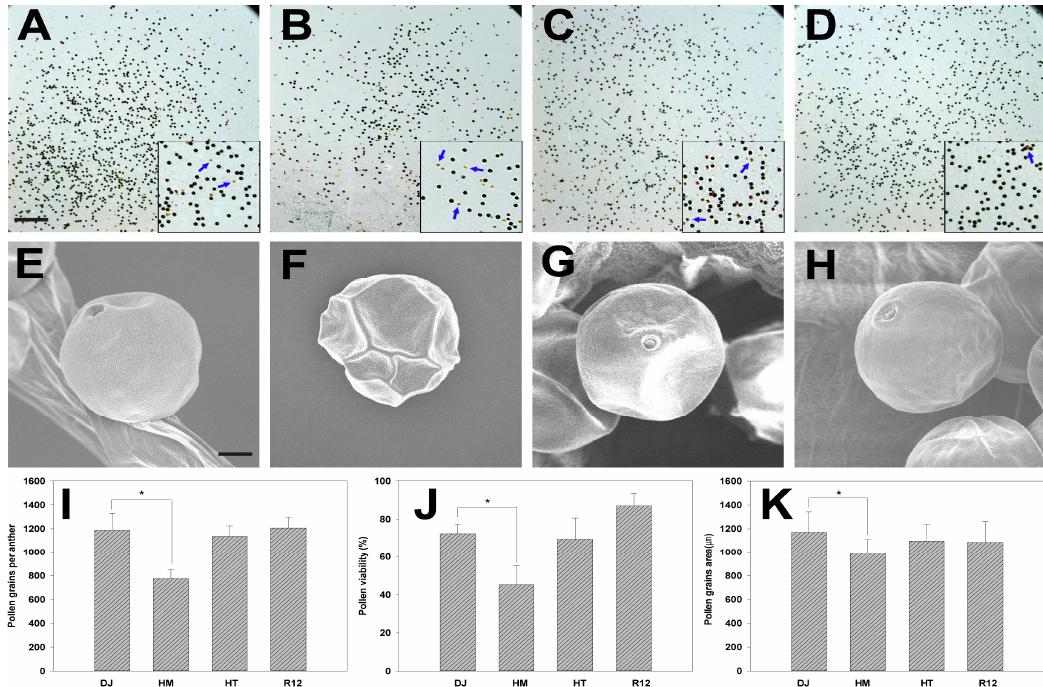
Figure 4. Osfuct mutant affects pollen morphology, viability, and total number in the mutant (HM) and HT plant compared to Dongjin. Pollen grains were stained with 80% ( w / v ) potassium iodide and 10% iodine. The black stain indicates viable pollen grains, whereas non-viable pollen grains are stained yellow ( A – D ). In inset (black box), solid blue arrow indicates the non-viable pollen ( A ) Dongjin, ( B ) HM, ( C ) HT, and ( D ) rescue (R12). Scale bar is 10 µ m. Pollen morphology of mutant, rescue, and wild-type plants ( E – H ): ( E ) Dongjin, ( F ) HM, ( G ) HT, and ( H ) rescue (R12). The mutant produced